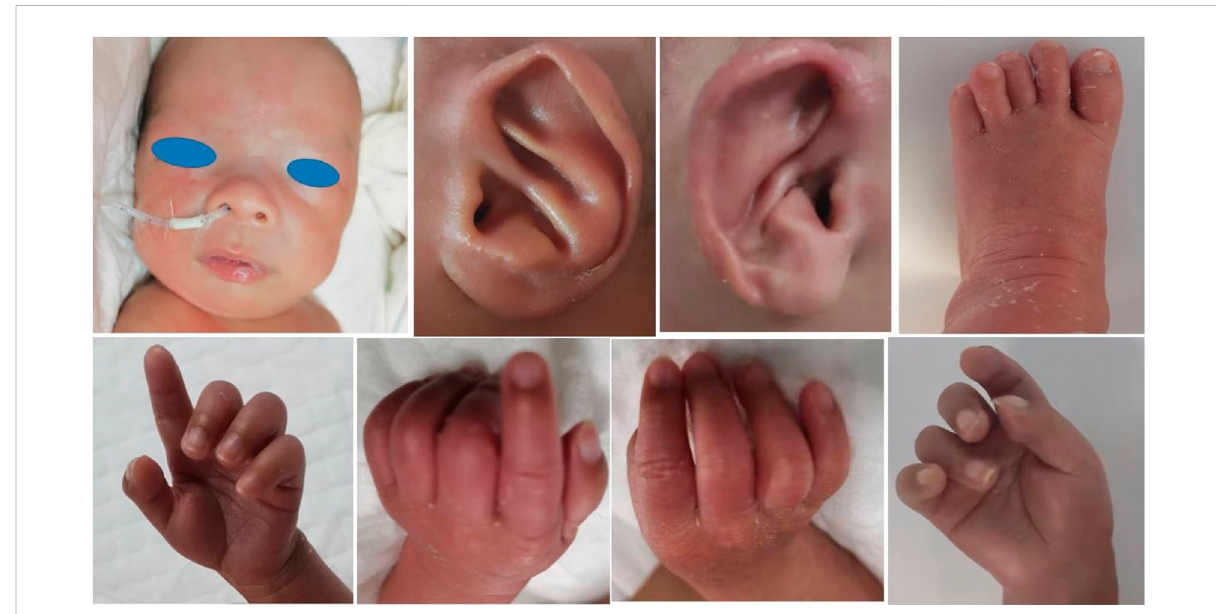
FIGURE 1 Patient Ⅰ : sparse eyebrows and hair, prominent forehead, wide eye distance, wide nose bridge, and prominent antihelix stem. His bilateral third, fourth, and fi fth fi ngers were camptodactyly. Mild deformity of the left toe was also